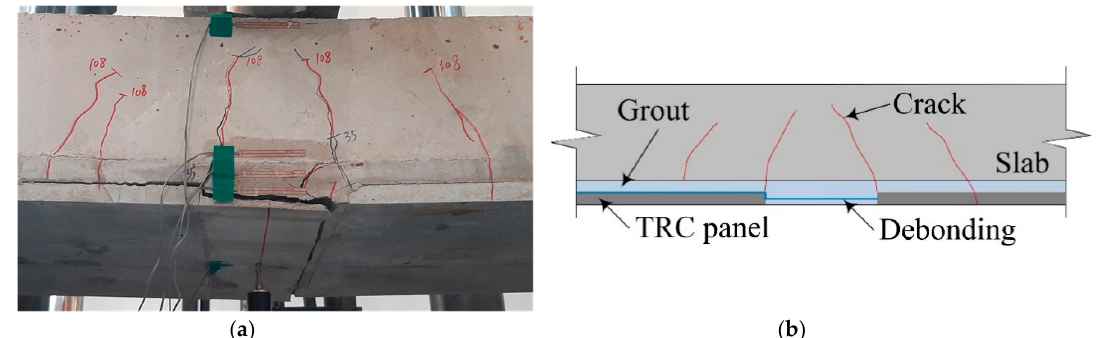
Figure 17. The S-2-1 specimen: ( a ) lap-spliced joint; and ( b ) failure mechanism.